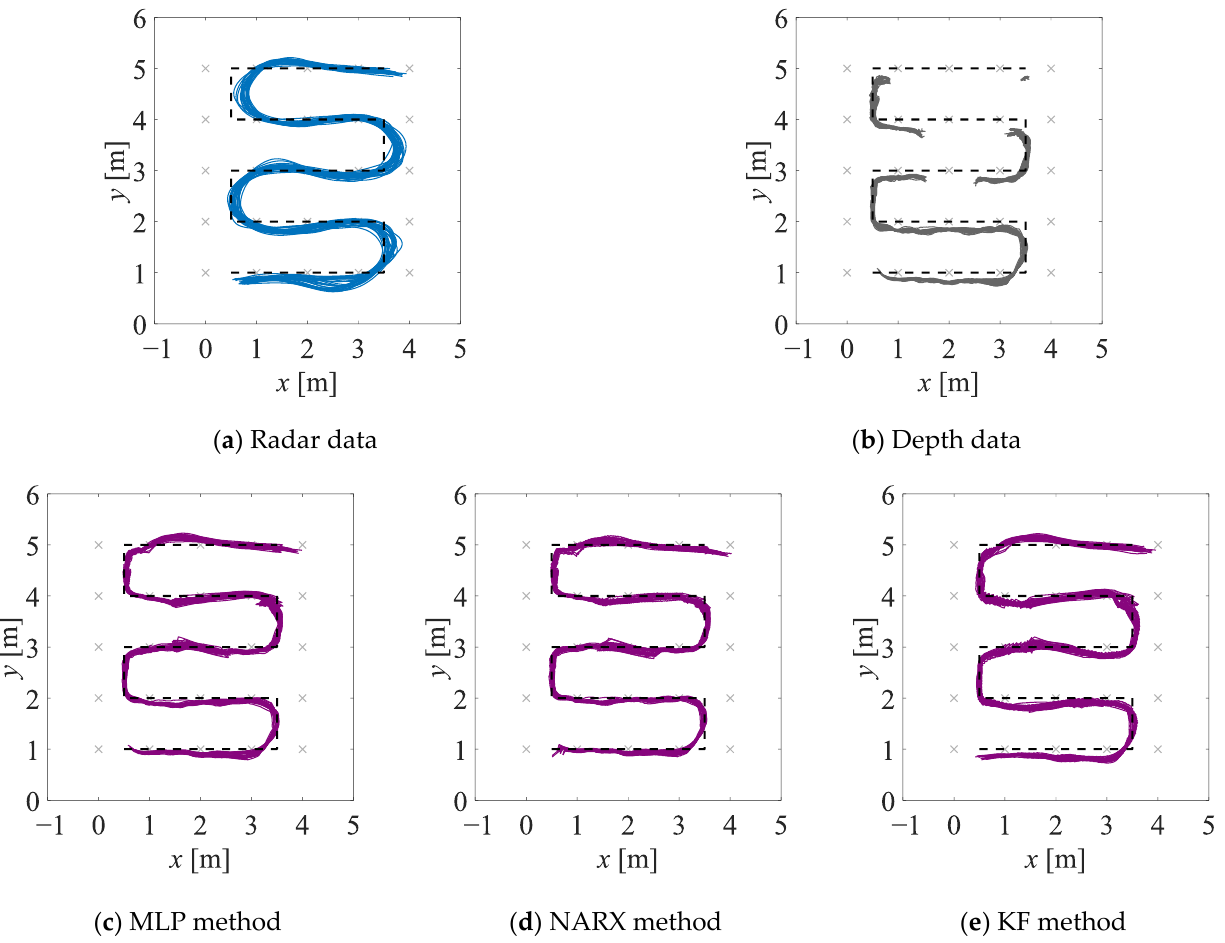
Figure 5. Estimates of the trajectories obtained in experiment EXP#1, on the basis of the radar data ( a ), the depth data ( b ), and the fused data ( c – e ); the black dashed lines denote the reference trajectories.